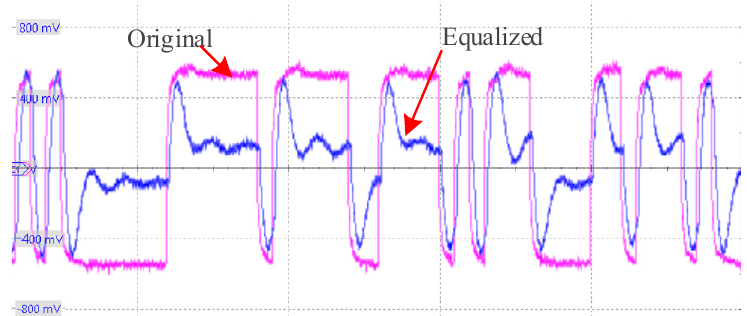
Figure 9. 100 Mbps signal with and without pre-equalization.